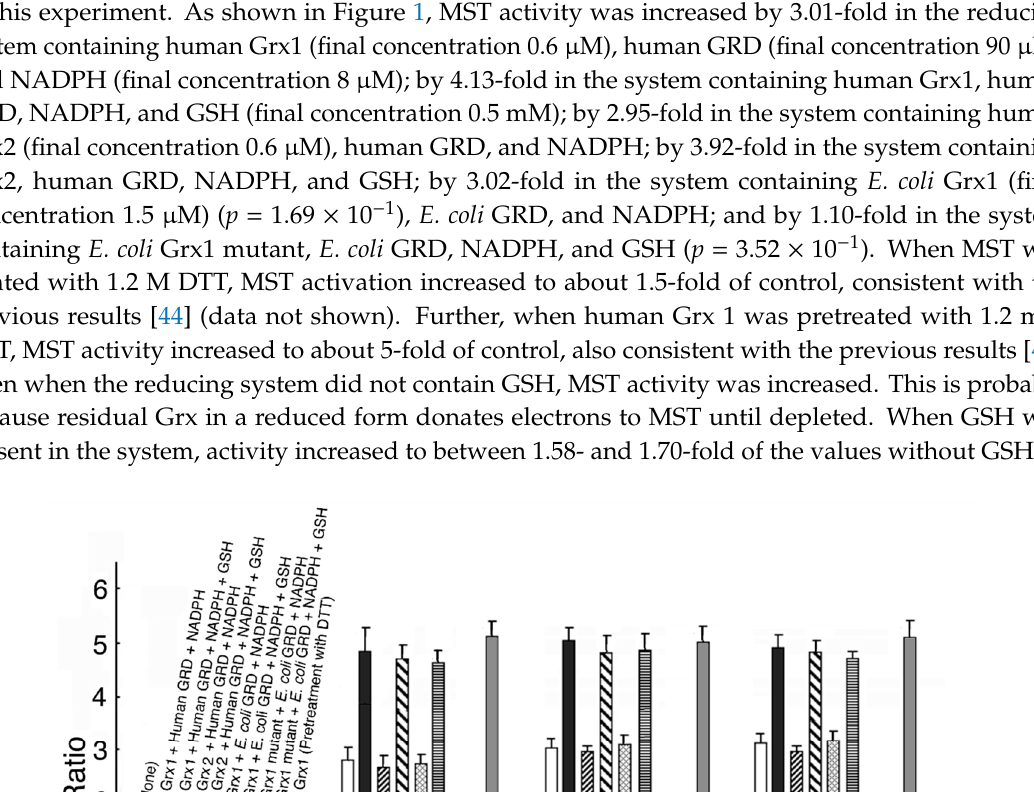
Figure 2. Human Grx1 and GSH dose-dependent MST activation. ( A ). The MST reducing system contains various concentrations of human Grx1, human GRD, and NADPH without GSH. ( B) . The MST reducing system contains human Grx1, human GRD, and various concentrations of NADPH without GSH. ( C) . The MST reducing system contains human Grx1, various concentrations of human